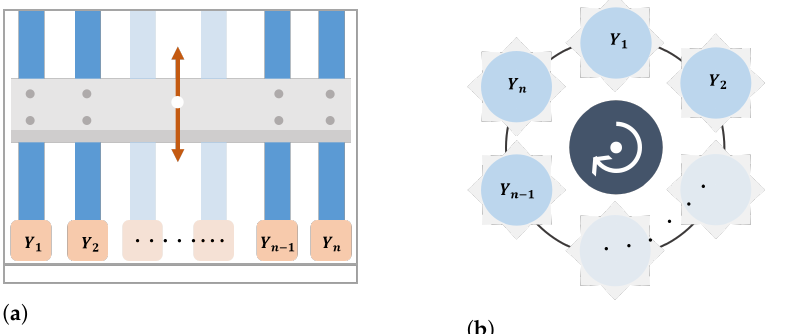
Figure 1. Schematics of multi-actuator-driven gantry. ( a ) Linear motion system. ( b ) Rotational mo- tion